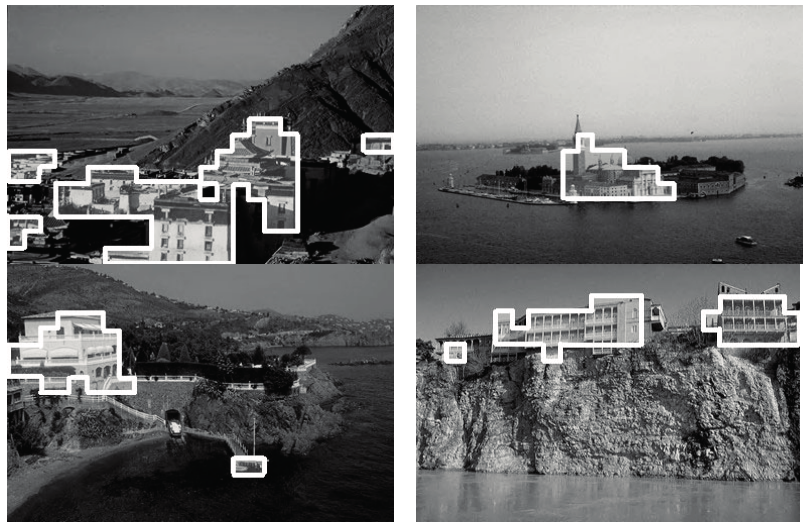
is (cid:3036)(cid:3037) and (cid:1851) . (cid:3036)(cid:3037) (cid:2919)(cid:2920)